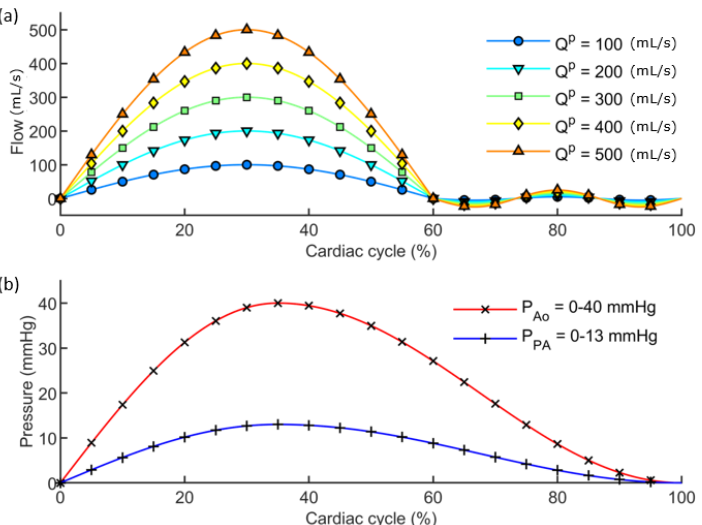
Figure 2. ( a ) Inflow boundary conditions related to the five flow peak Q p values implemented; ( b ) Outflow boundary conditions related to the two implemented pressure ranges ( P Ao and P PA